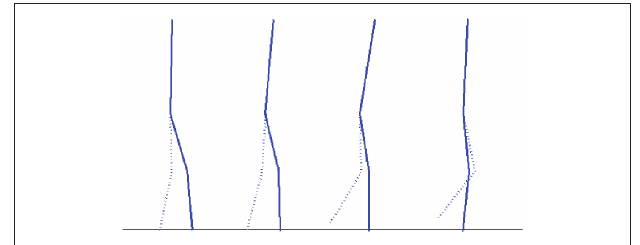
FIGURE 11 | Motion sequence of the kneed biped walker for the parameters ε = 0.10, ε = 0.10, output Gain G = 10. The body and the 1 2 controllers mutually entrain themselves with each other in an emergent manner. The body dynamics feeded back to the controllers contribute to regulate its own motion.